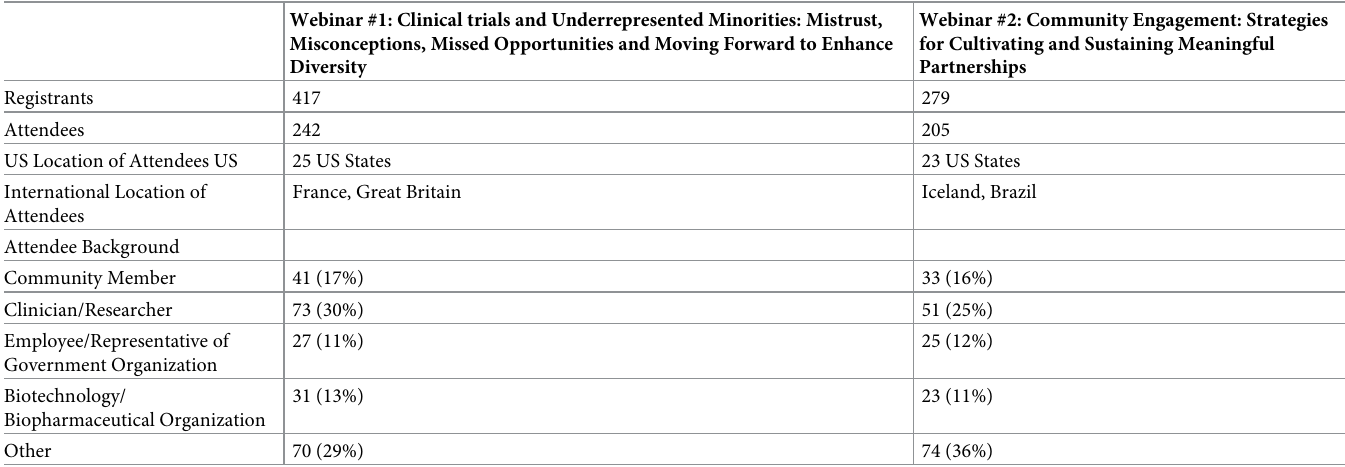
Table 3. Demographics of webinar #1 and #2